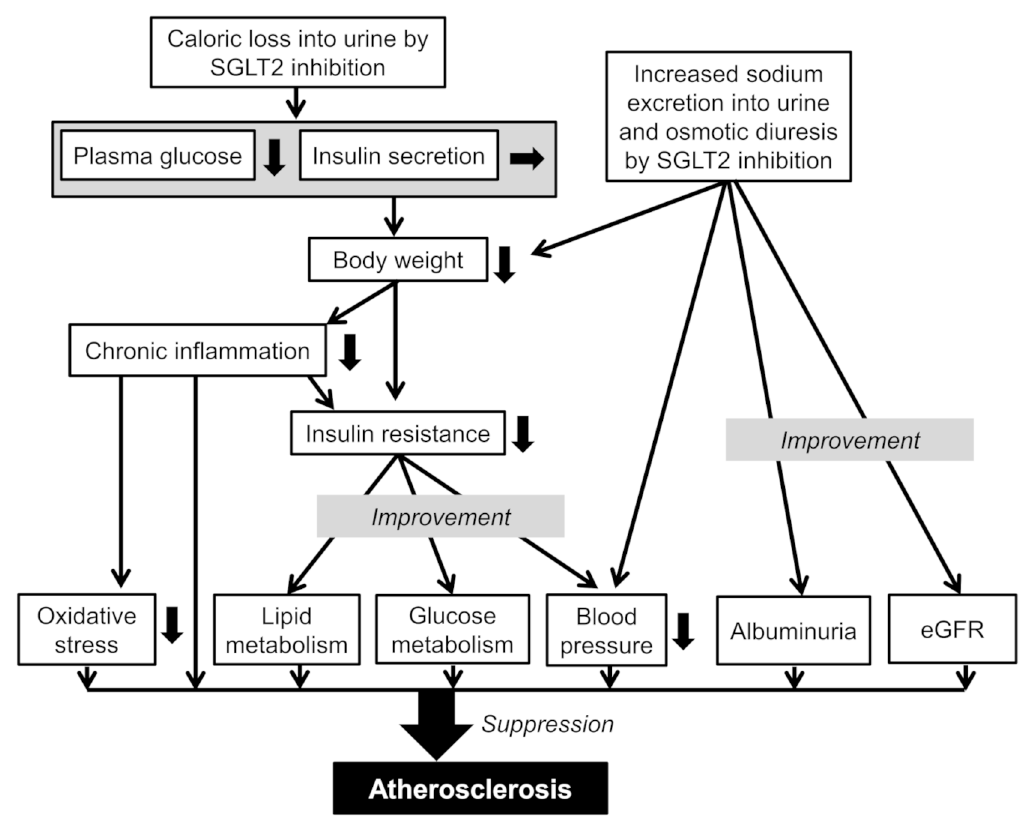
Figure 1. Possible anti-atherosclerotic mechanisms of sodium glucose cotransporter 2 inhibitors (SGLT2i) inhibitors. The bold down arrows indicate a